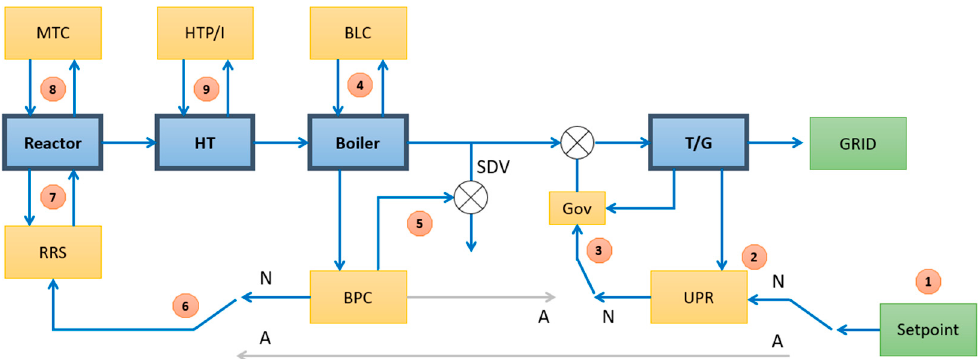
Figure 3. Modes of an NPP’s operation—normal mode.